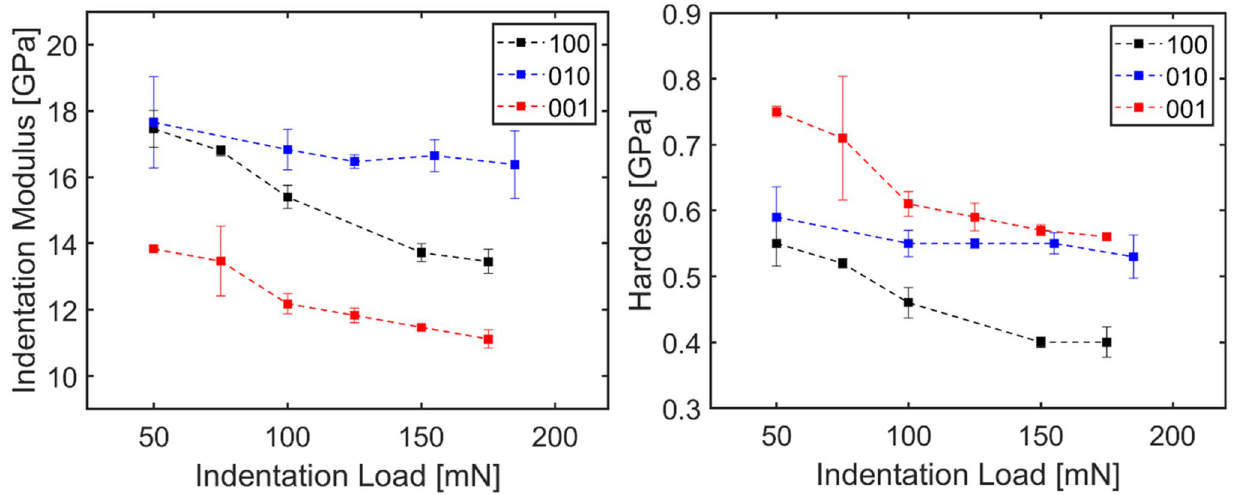
Fig. 8 Anisotropic behavior of β-HMX crystal planes with respect to modulus and hardness